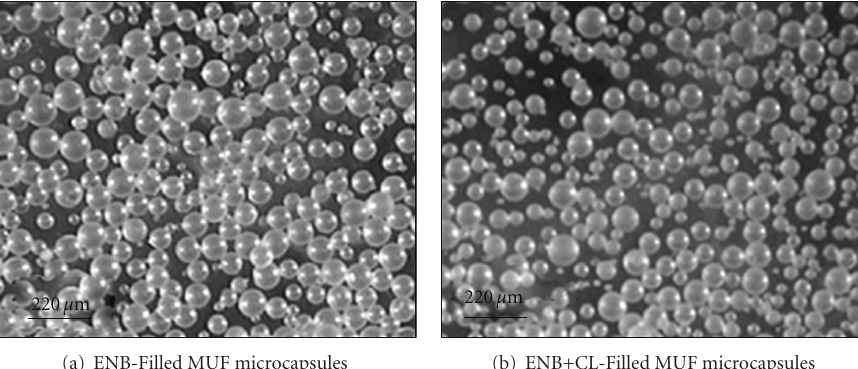
Figure 4: Optical microscopic images of ENB- and ENB + CL-filled MUF microcapsules with no debris formed ( M/U/F = 3:1 :8.5, reaction temperature = 86 ◦ C, rpm = 500). Copyright Macromol. Mater. Eng.